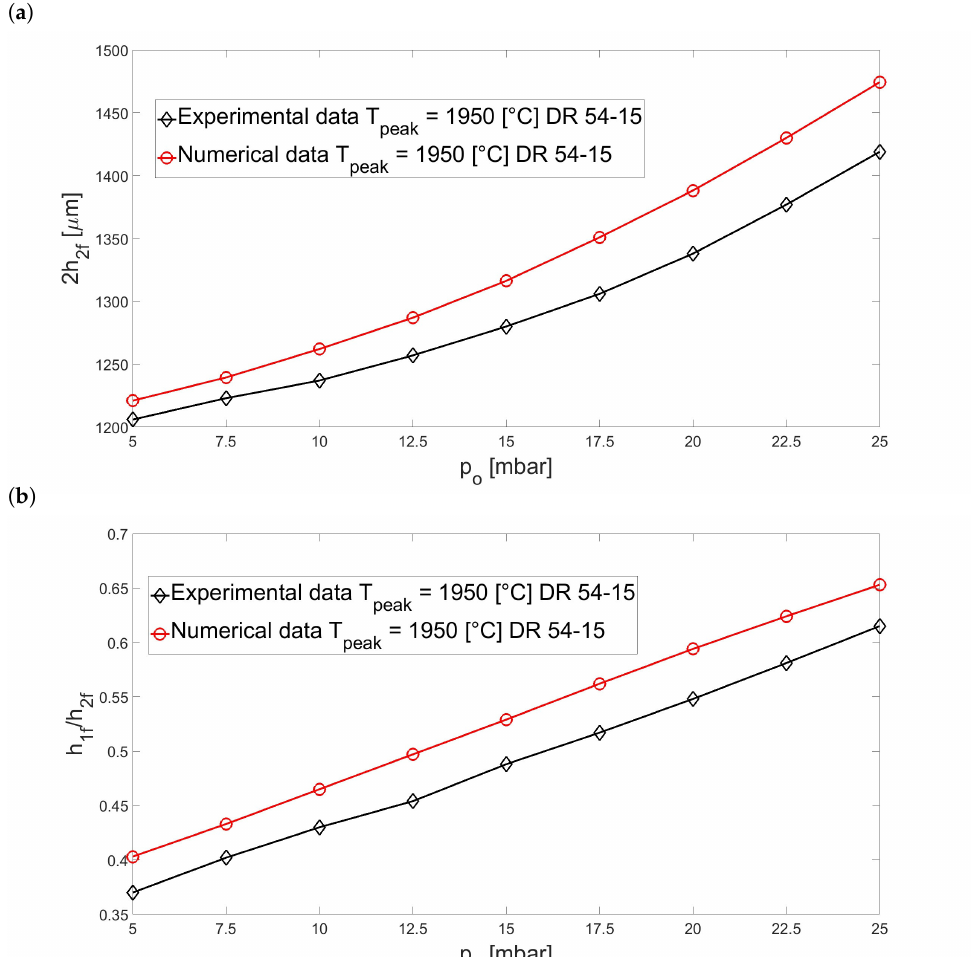
Figure 8. Comparison between the final outer diameter ( a ) and air-filling fraction ( b ) of the cap- illary obtained numerically and experimentally by Luzi et al. [20] for different values of internal pressurization and a fixed value of the furnace peak